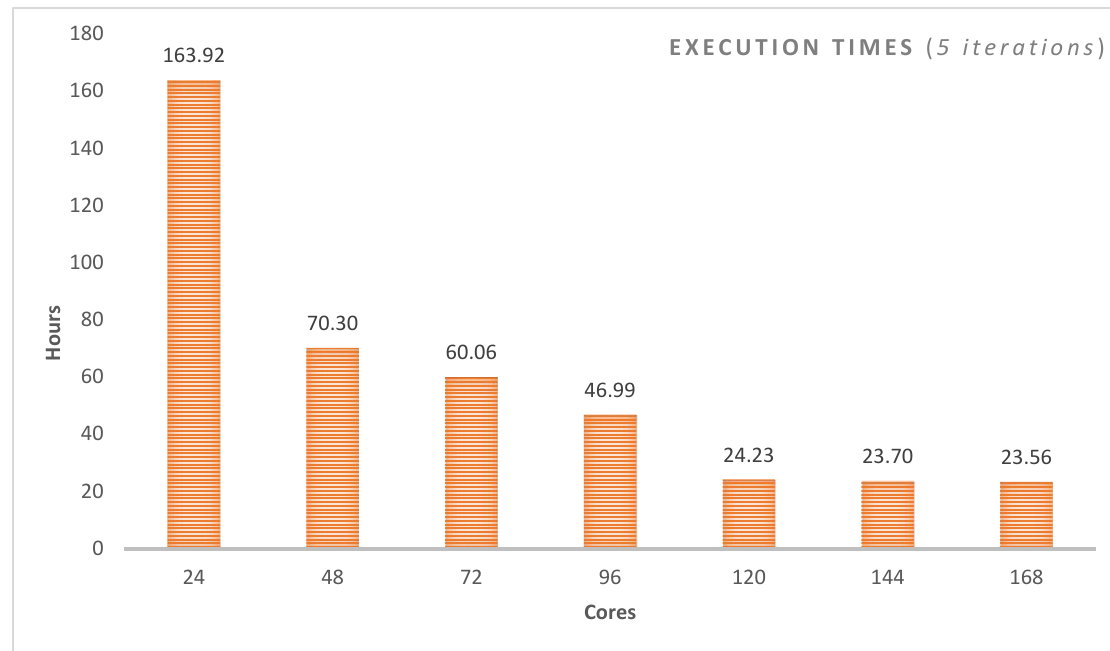
Figure 16. Execution time vs. number of cores for varying number of LDA iterations (no limit on the number of features).